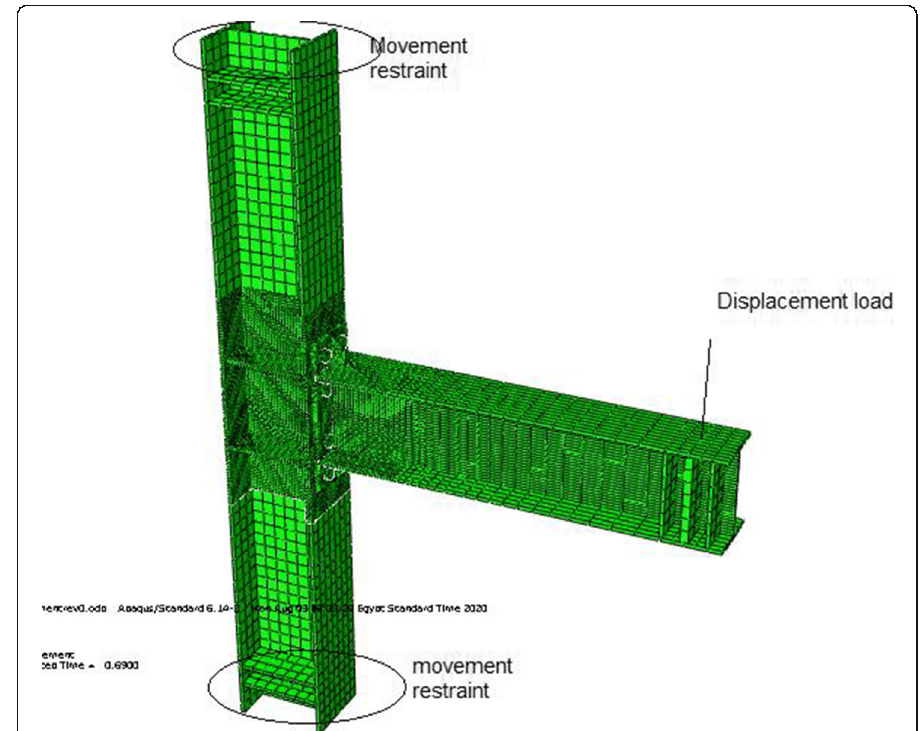
Fig. 2 End-plate moment connection simulation (SC2)